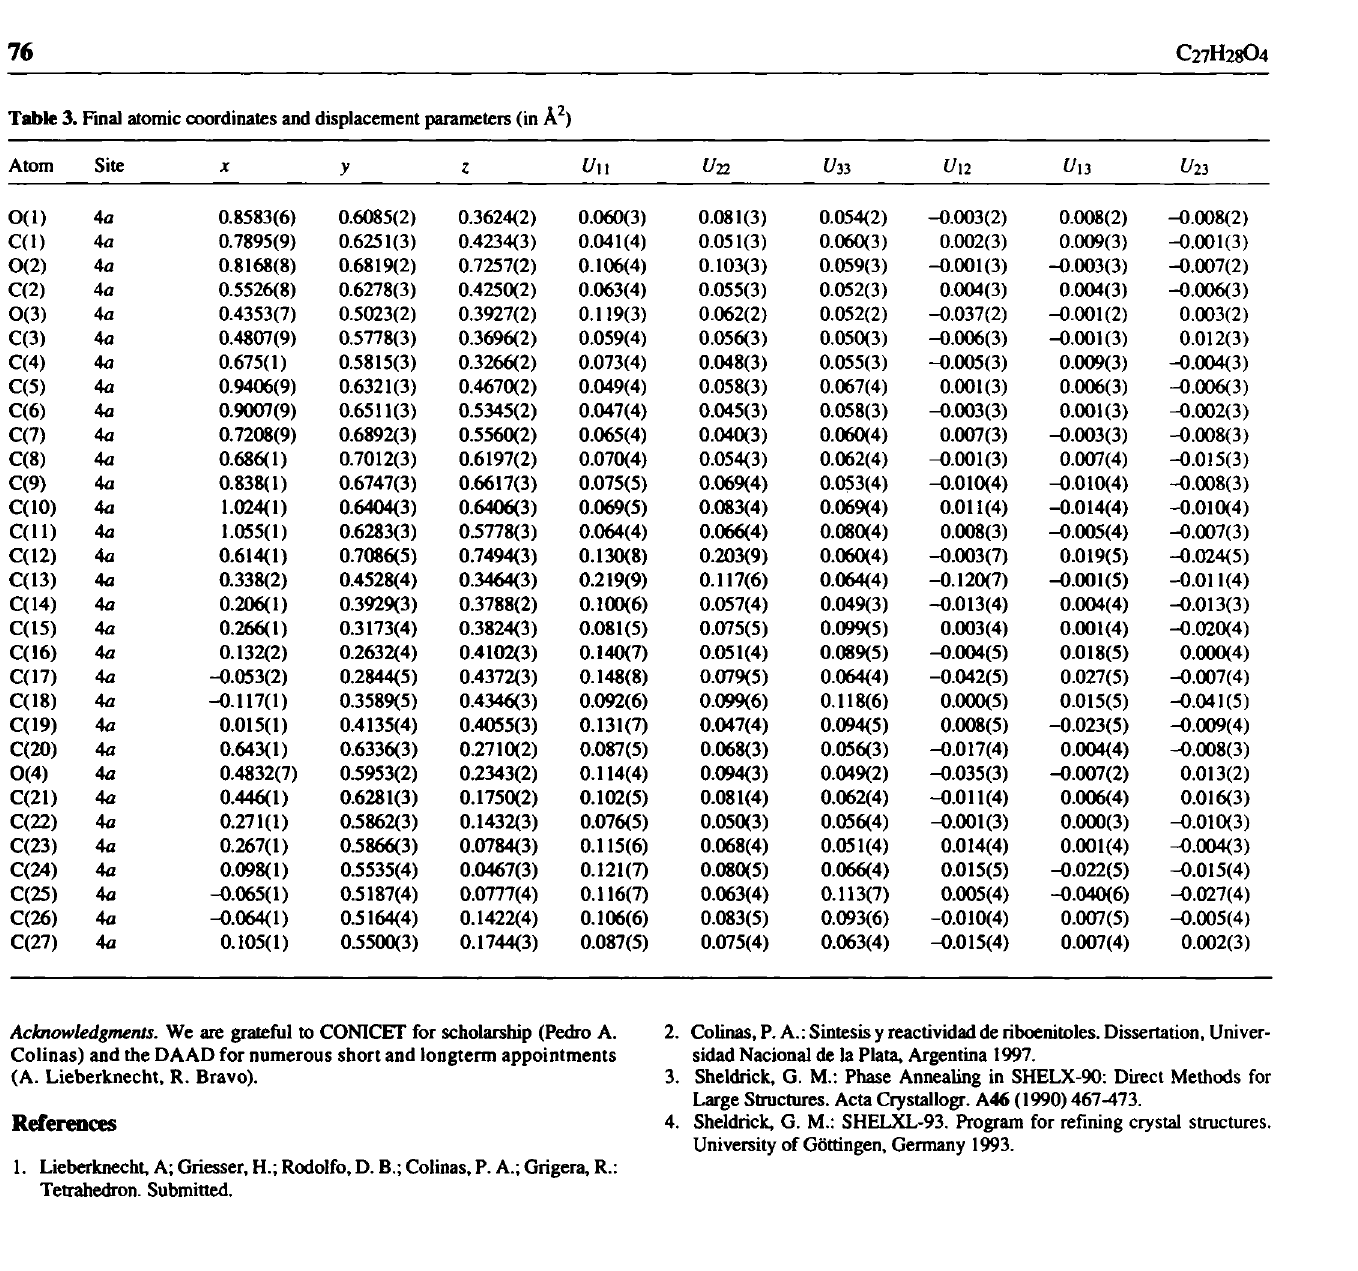
Table 3. Fmal atomic coordinates and displacement parameters (in Â^)